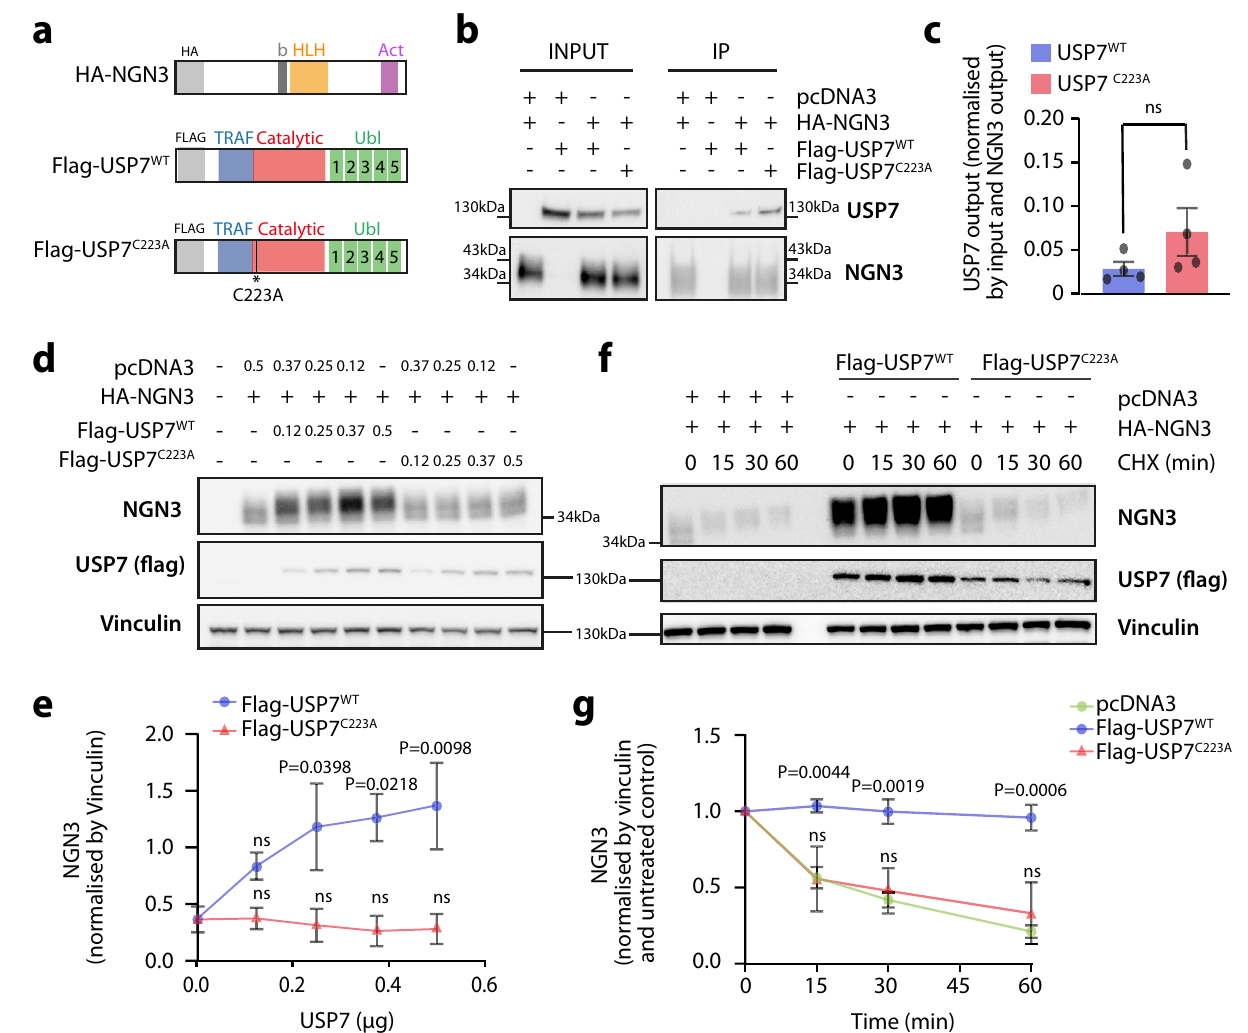
Fig. 1 | USP7 modulates NGN3 stability through direct protein – protein inter- actionsinHEK293Acells.a SchematicoftheproteinstructuresofHA-NGN3,Flag- USP7 WT , and Flag-USP7 C223A . b Immunoblotting for NGN3 and USP7 (Flag) in an HA- NGN3 immunoprecipitationexperiment inHEK293Acells. c Quanti fi cation ofFlag- USP7 WT and Flag-USP7 C223A in the output of HA-NGN3 immunoprecipitation experiments, normalized by immunoprecipitated NGN3 levels and USP7 input levelsineachsample.Bargraphsrepresentmean±SEM,andstatisticalsigni fi cance was determined by two-tailed Student ’ s t -test ( n =4 biologically independent experiments). d Immunoblotting for NGN3 in HEK293A samples co-transfected withincreasingconcentrationsofFlag-USP7 WT orFlag-USP7 C223A . e Quanti fi cationof NGN3, normalized by Vinculin ( n =3 biologically independent experiments). The plotrepresentsmean±SEM,andstatisticalsigni fi cancewasdeterminedbytwo-way